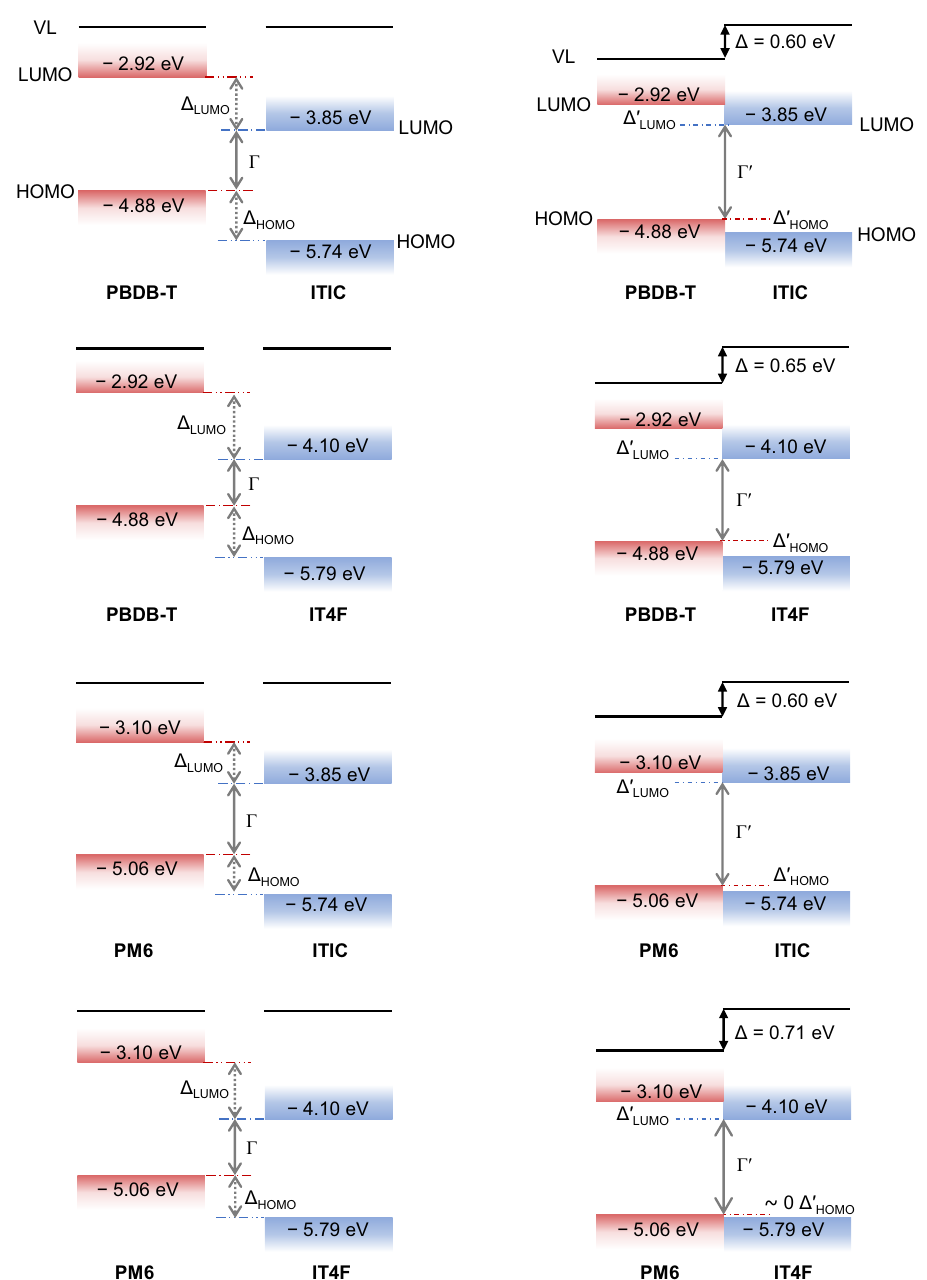
Δ Δ ′ – A LUMO ( LUMO ). Photovoltaic gap at the D